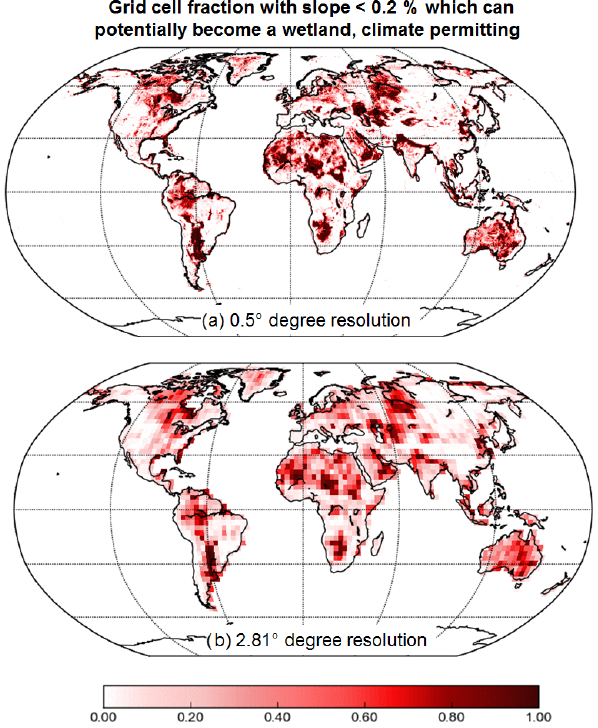
Figure A1. Fraction of grid cell with slopes less than the threshold of 0.002 (i.e. 0.2% slope) at (a) 0.5 ◦ and (b) 2.81 ◦ spatial resolu- tions,